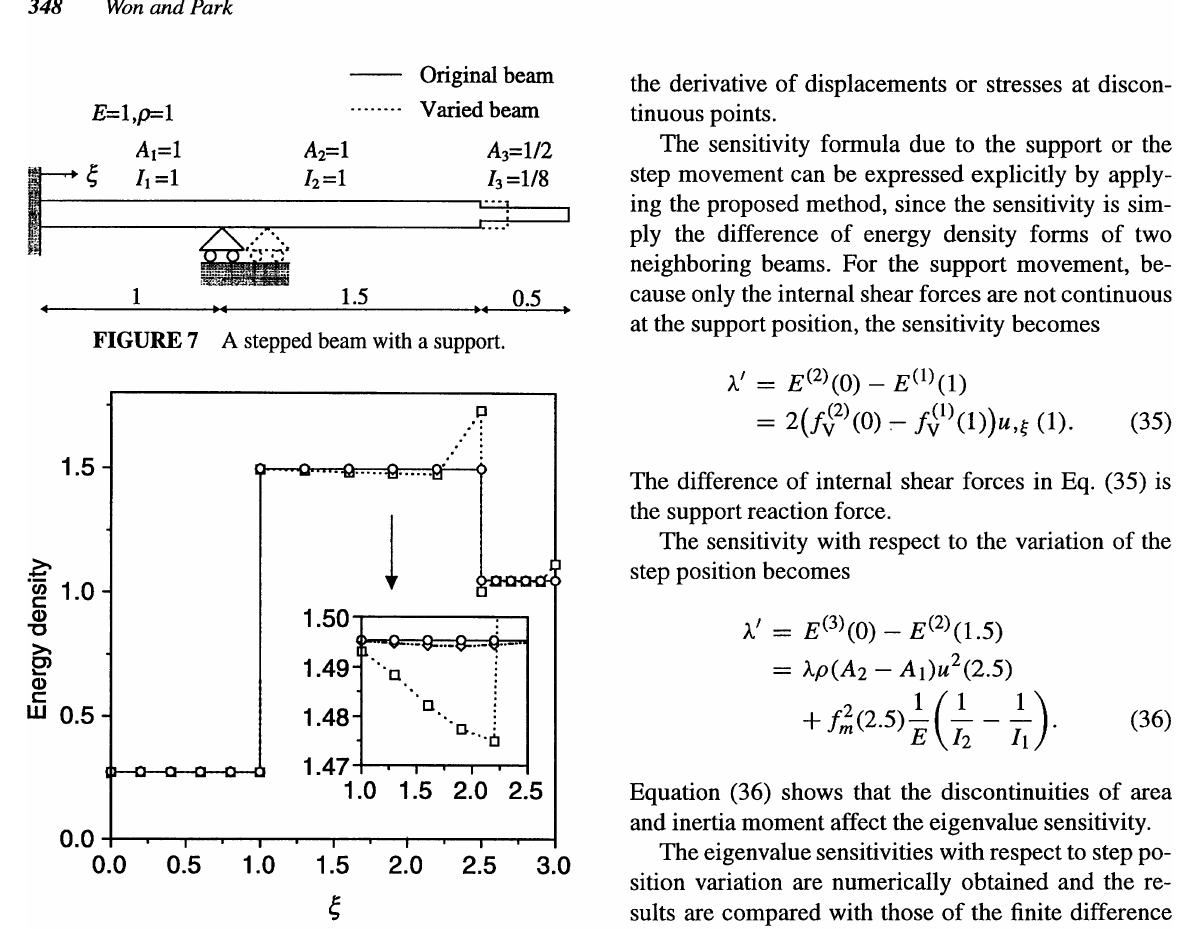
FIGURE 8 Energy densities of a stepped beam with a support (0: displacement method, 0: mixed method, and 0: force